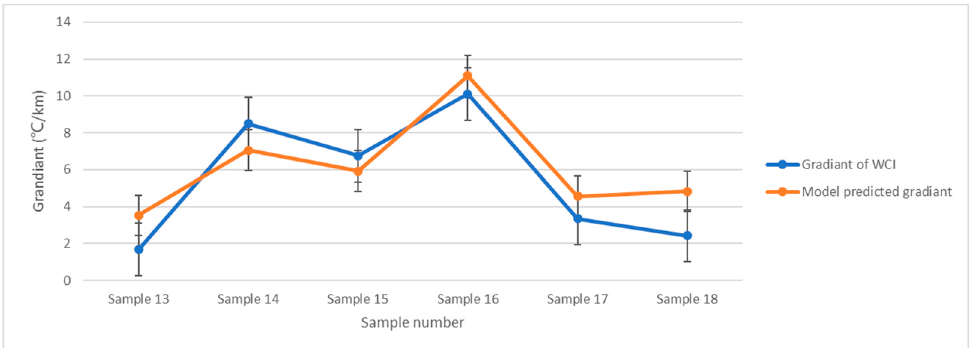
Figure 7. Regression model validation of WCI gradient by estimating the other 6 samples.